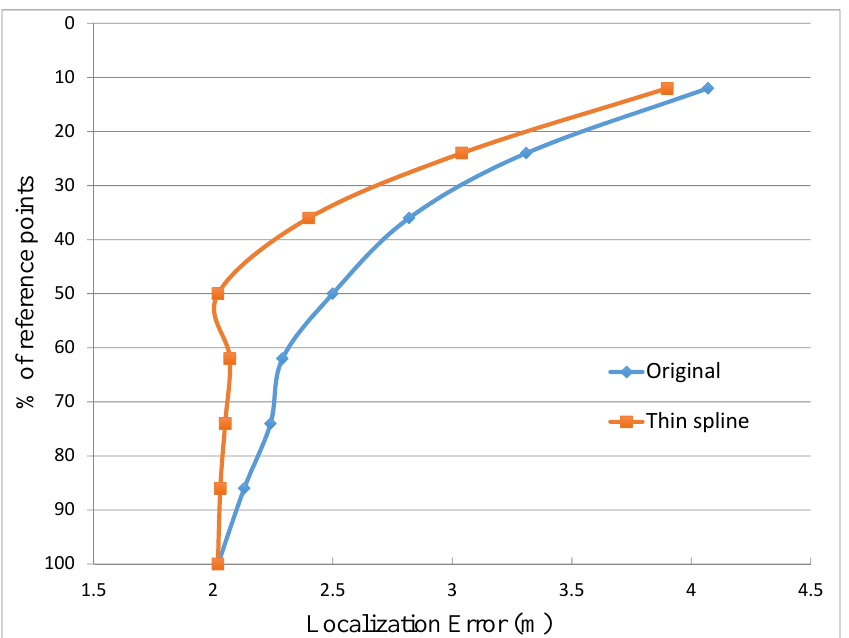
Figure 7. Percentage of reference points included in the database against the localization error for the original case without interpolation and using thin spline